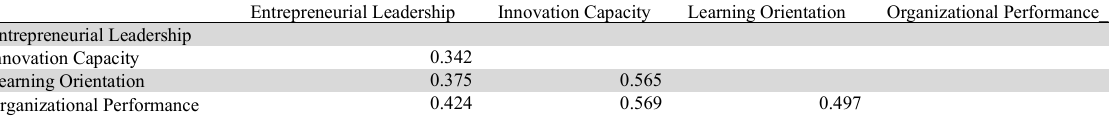
Discriminant Validity (HTMT)